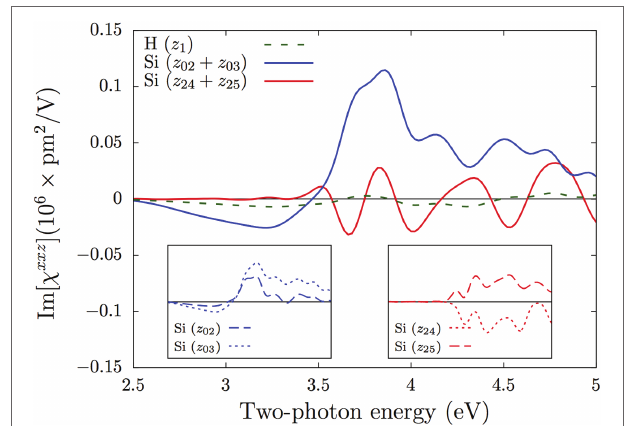
FIGURE 2 | Main plot: imaginary part of (cid:31) xxz ( z n ) for the H layer ( z 1 ), the sum of the two topmost Si layers ( z 2 + z 3 ), and the sum of the bottom-most Si layers ( z 24 + z 25 ) for the 25-layer half-slab used in this work . Left inset: the first two Si layers at z 2 and z 3 . Note how the spectra are almost identical in line shape, thus enhancing the overall component intensity. Right inset: the last two Si layers at z 24 and z 25 . The individual spectra are almost opposite in sign, thus producing a much smaller